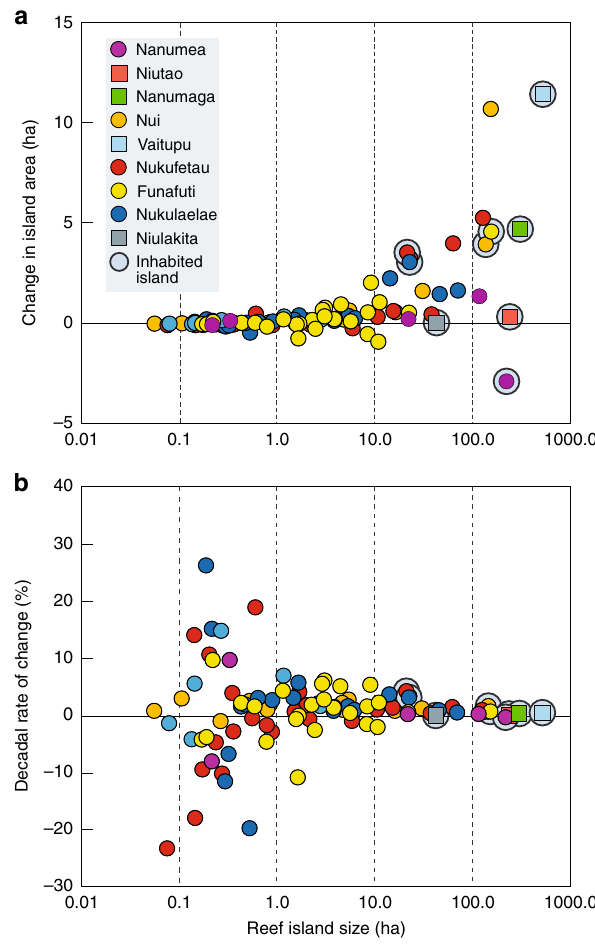
Fig. 1 Summary data of physical island change of islands in Tuvalu between 1971 and 2014. a Absolute changes in island area in hectares with respect to island size. b Percentage change in islands per decade with respect to island size. Raw data contained in Supplementary Data 1. Note: square symbols denote reef platform islands; solid circles denote atoll rim islands; and light blue circles enclosing symbols denote populated